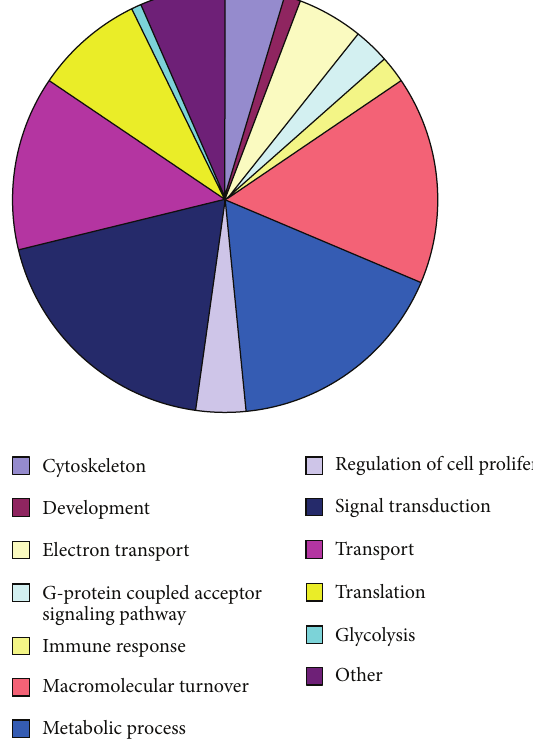
Figure 5: Estimated fractions of cellular transcripts based on gene ontology in the liver tissues of control and diabetic groups. Biological process categories for liver tissues of control tree